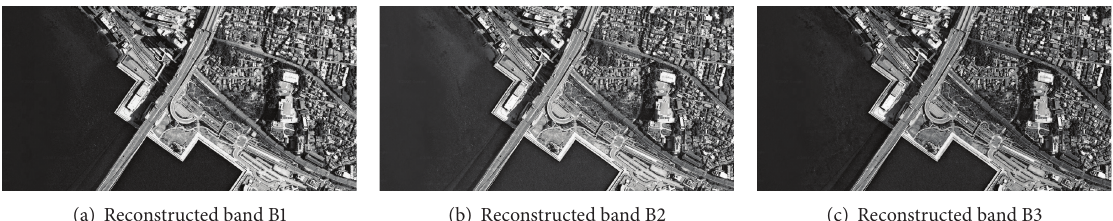
Figure 6: Encoding multiband images at 2.0 bpp.